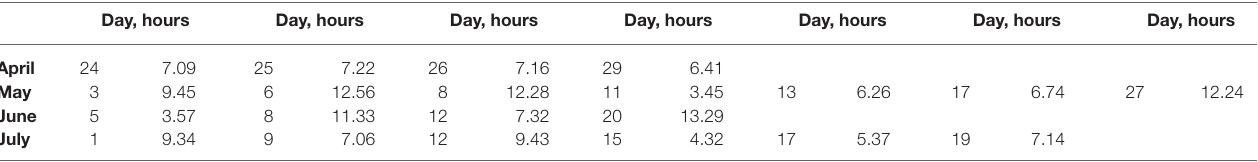
TABLE 2 | Number of hours recorded by the APDM sensors per each day session across the 4 months